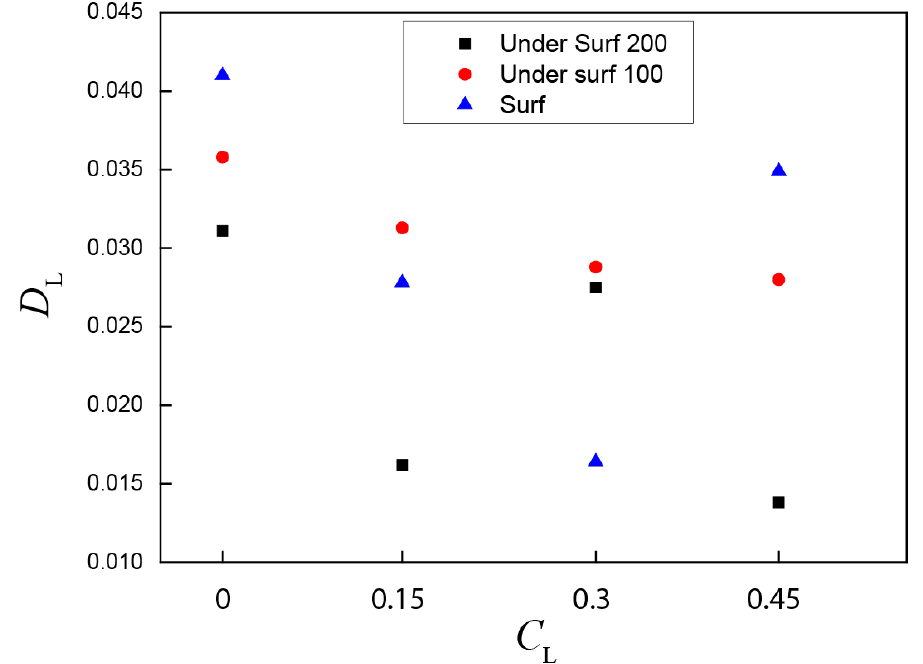
Figure 7. The variance in the velocity difference between PIV measurements and numerical simulation at −100 mm to 100 mm in Figures 5 and 6.